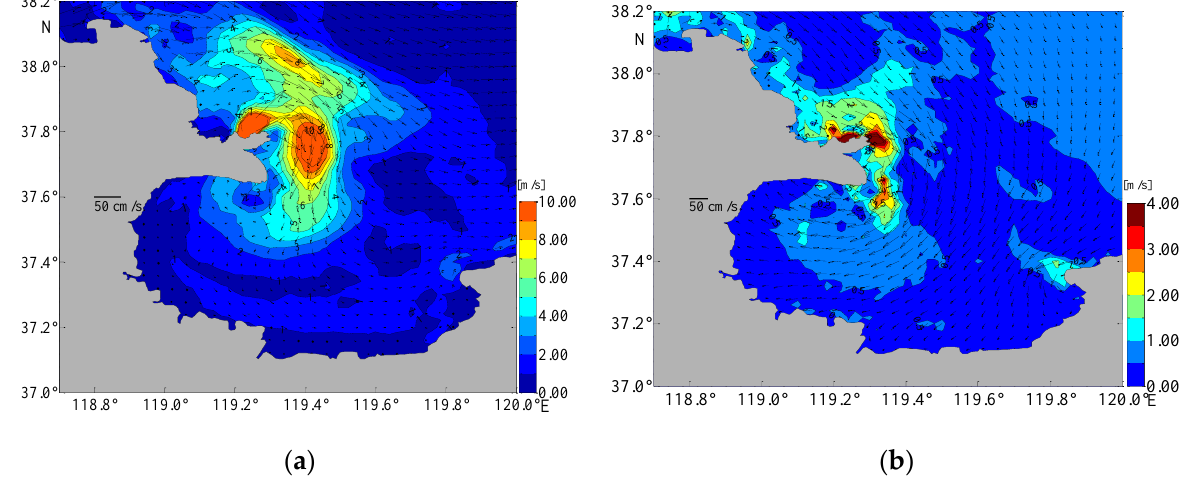
Figure 9. Distribution of the surface residual current field in the wet season ( a ) and the dry season ( b ).